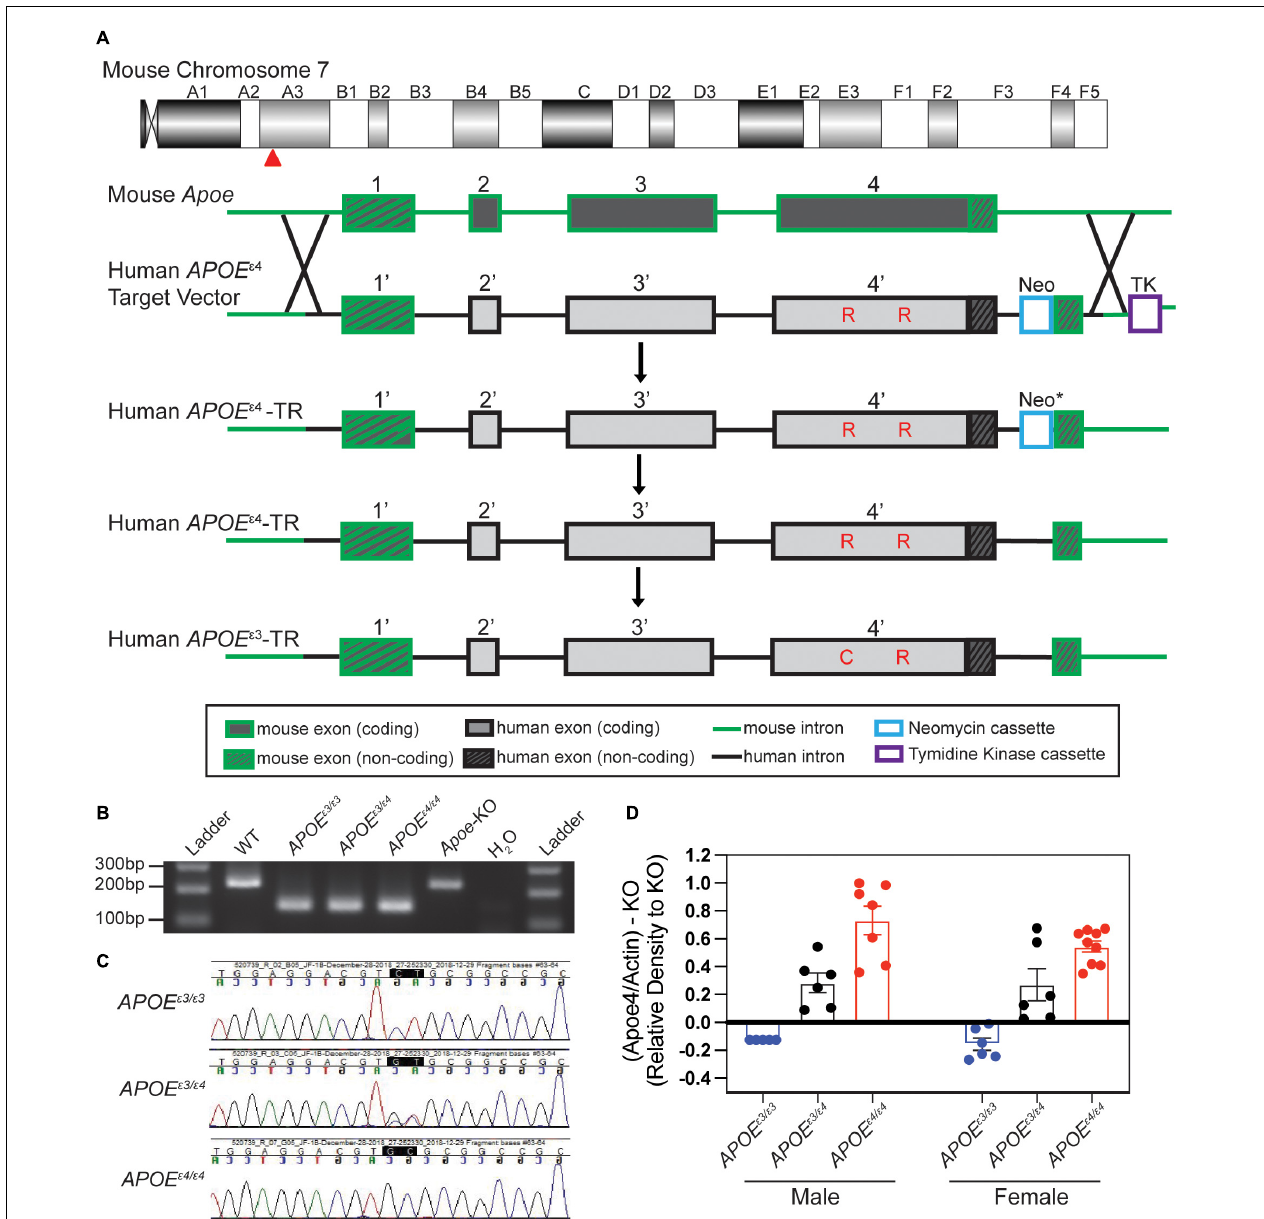
FIGURE 1 | Creation and validation of APOE allelic series. (A) Schematic of human APOE allele insertion at the mouse Apoe locus on chromosome 7. Exon 1 remained unchanged (mouse) and exons 2–4 were replaced with human APOE ε 4 sequence through homology directed repair (HDR). The neomycin cassette was removed (* indicated by asterisk) through Flp-Frt breeding (Flp-Frt sites not shown). The APOE ε 3 SNP was changed through CRISPR mediated endonuclease activity. Critical amino acids differing between APOE ε 4 and APOE ε 3 noted in red. (B) PCR based assay to identify humanized APOE insertions at exon 2 vs. WT mouse Apoe (no insertion) at exon 2. (C) Sanger sequencing to distinguish APOE ε 3 and/or APOE ε 4 alleles. (D) Western blotting revealed significant differences in APOE ε 4 levels between